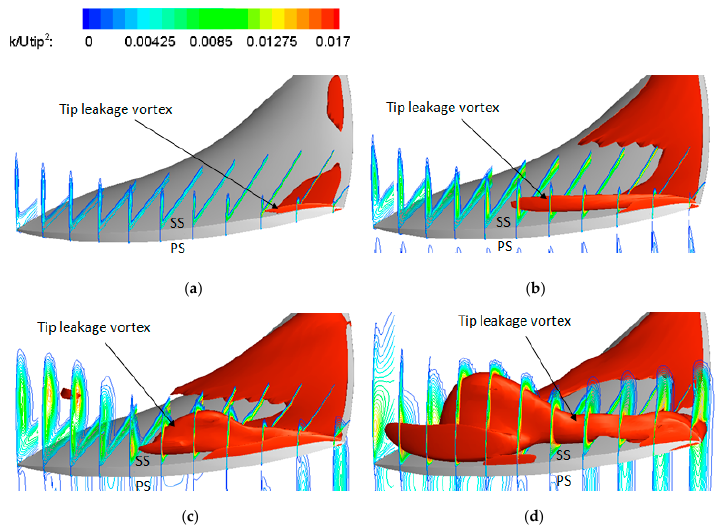
Figure 13. Flow patterns for varying discharges around the blade. Isosurface of non-dimensional turbulence kinetic energy (TKE) for a value of 0.017 and magnified isolines of non-dimensional TKE (( a ) ϕ = 0.4; ( b ) ϕ = 0.354; ( c ) ϕ = 0.329; and ( d ) ϕ = 0.303).